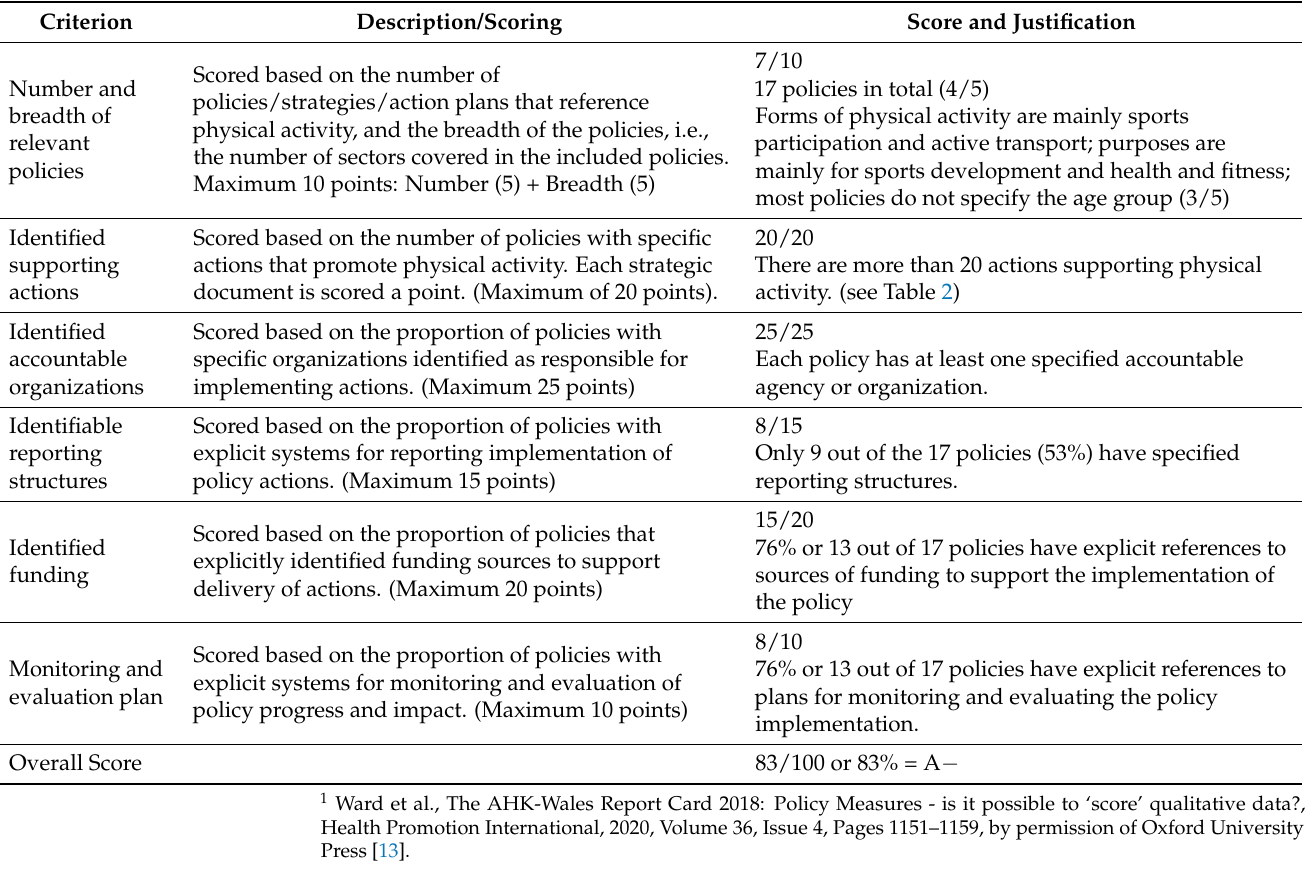
Table 3. Evaluation of Philippine policies based on the AHK-Wales scoring rubric 1